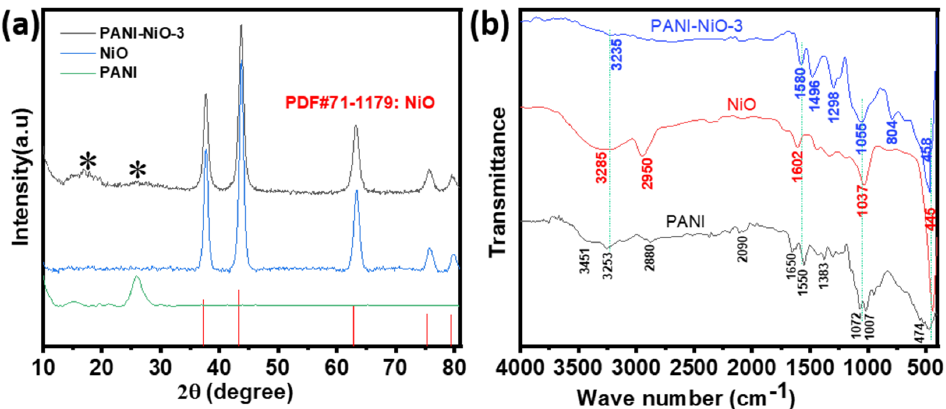
Figure 3. ( a ) XRD pattern of PANI, NiO, and PANI-NiO-3, and ( b ) FTIR spectra of PANI, NiO and